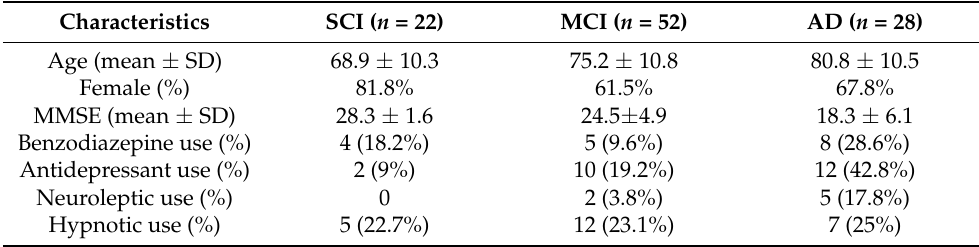
Table 1. Clinical characteristics of the